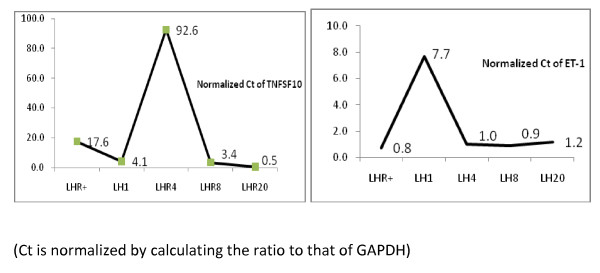
qRT-PCR measures of gene TNFSF10 and ET-1. The left panel shows the normalized Ct of TNFSF10 (primer sequence (F) AAGACTGTCAGCTTCCAAACATTAA(R) GTGATACACTACT TGAGAGATGGAT) and the right panel shows the normalized Ct of ET-1 (primer sequence (F) AGGCCCTGAGTTGGCAGTGGCCCAT (R) ATGGGCCACTGCCAACTCAGGGCCT).